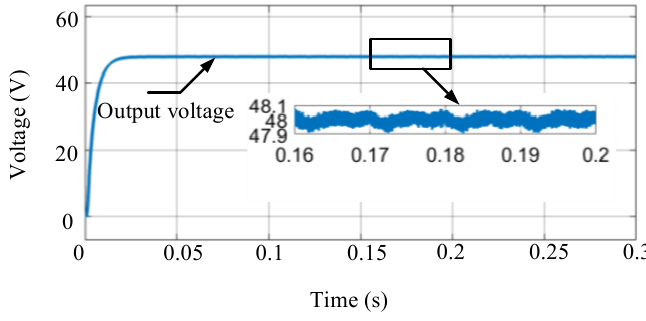
Figure 22. Output voltage of the rear stage.